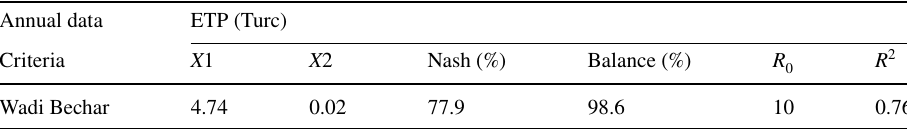
Table 3 Values of the parameters after calibration and performances of the Wadi Bechar watershed